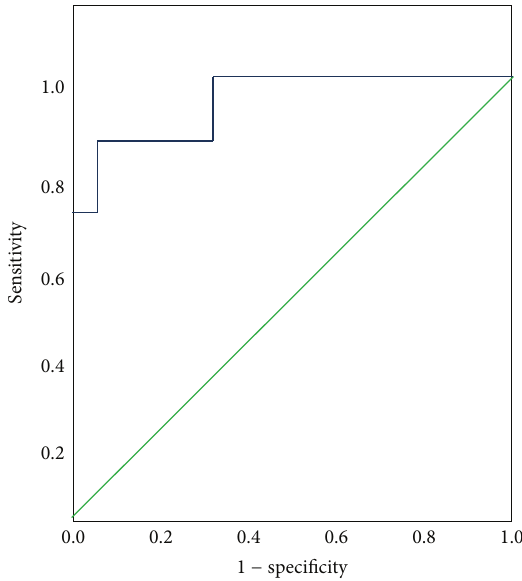
Figure 3: The receiver-operating characteristic (ROC) analysis curve for ADA in tuberculous meningitis and nontuberculous meningitis. Area under curve (AUC) =